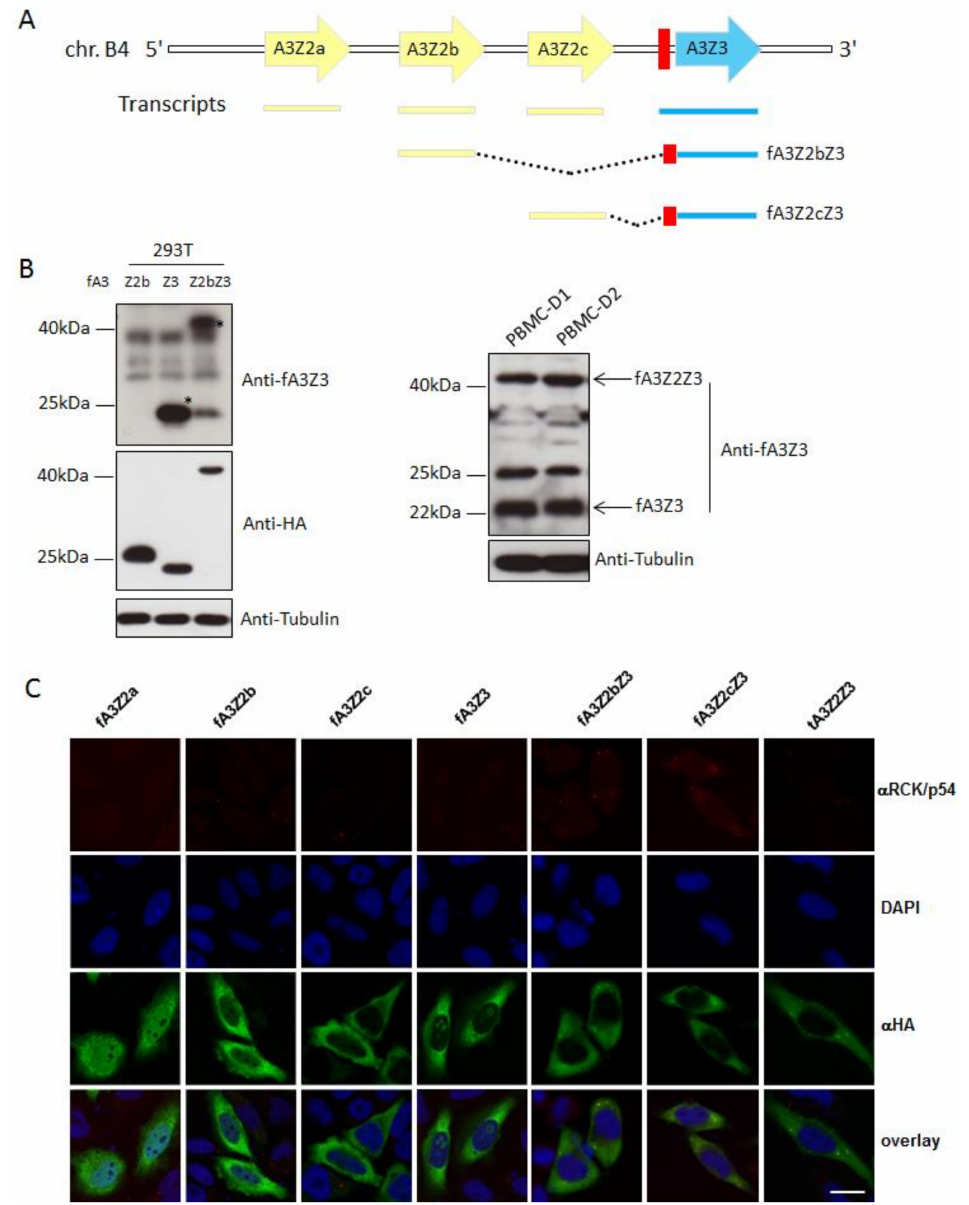
Figure 3. The expression and cellular localization of feline APOBEC3s. ( A ) Representation of APOBEC3 (A3) genes in the genome of Felis catus . Coding regions of the A3 genes ( A3Z2a , A3Z2b , A3Z2c and A3Z3 ) are shown as arrows. Red rectangle: exon 2 of A3Z3 that is untranslated in the A3Z3 mRNA, however translated (“linker domain”) in read-through transcripts A3Z2bZ3 and A3Z2cZ3; ( B ) 293T cells transfected with feline A3Z2b, A3Z3, and A3Z2bZ3 expression plasmids were harvested for immunoblotting by using polyclonal rabbit serum raised against fA3Z3 and anti-HA antibodies. Asterisks indicate the detection of feline A3Z3 and feline A3Z2bZ3 proteins. Cat PMBCs from two donors were stimulated with concanavalin A and then cultured with 100 U/mL IL-2. The Expression of cat A3Z3 and A3Z2Z3 proteins in stimulated peripheral blood mononuclear cells (PBMCs) were detected by immunoblots using anti-fA3Z3 antibody. Tubulin served as a loading control; ( C ) Hela cells were transfected with feline A3s expression plasmids with a HA tag. To detect A3 (green) immunofluorescence, staining was performed with an anti-HA antibody. Nuclei (blue) were visualized by 4 (cid:48) ,6-diamidino-2-phenylindole (DAPI) staining. The cellular P-bodies were visualized by staining with anti-RCK/P54 antibody. Bar = 20 µ m. f indicates feline, t indicates